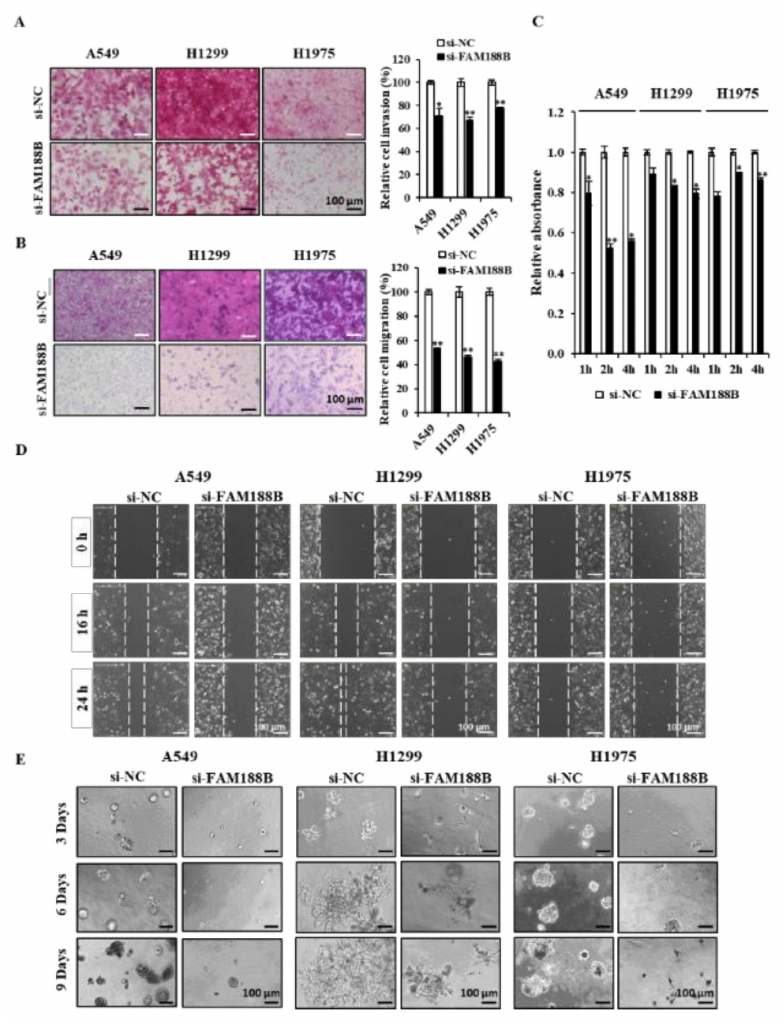
Figure 4. Effects of FAM188B knockdown on several metastatic characteristics in lung cancer cell lines. ( A – E ) Cells were transiently transfected with either si-NC or si-FAM188B for 24 h, followed by invasion assay ( A ), migration assay ( B ), adhesion assay ( C ), wound healing assay ( D ), and 3D culture ( E ) as described in the “Materials and Methods” and representative images are shown. For relative invasion and migration analysis, images were scanned to quantify three different areas (right panels in A , B ). For adhesion assay, 5 × 10 3 cells were plated in 96-well plate, and at indicated times, floating cells were removed by washing, and attached cells were measured by MTS assay ( C ). For wound healing assay, confluent cells were grown in 12-well plate, and cell monolayers were scratched with a pipet tip, and then cells were incubated for 24 h ( D ). For 3D culture, 5 × 10 3 cells in 400 µ L of 5% Matrigel were plated in the Matrigel-coated 8-well chamber as described in the “Materials and Methods”. Colony images were captured on indicated days ( E ). Scale bars = 100 µ m. Error bars represent standard deviations of the mean of three measurements (* p < 0.05, ** p < 0.01, versus si-NC). These experiments were performed three times independently with similar